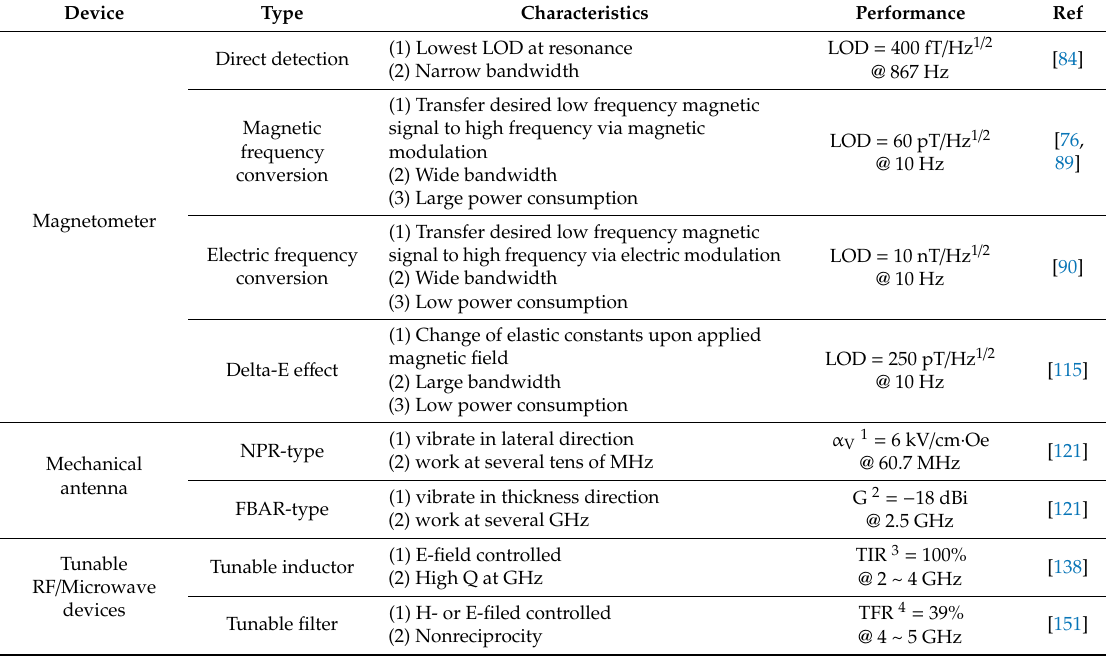
Table 2. Summary of characteristics for some of the reviewed integrated multiferroic